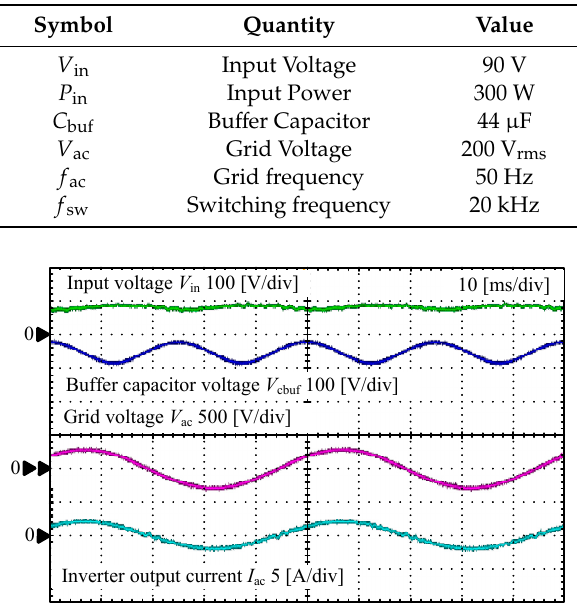
Figure 7. Experimental result of active power decoupling circuit and current source inverter (CSI).